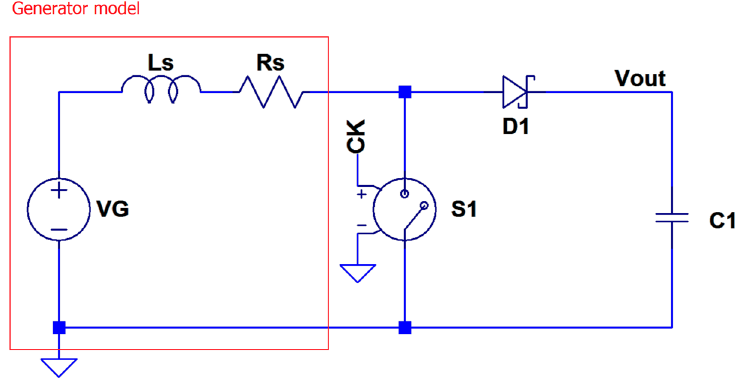
Figure 7. Simplifed boost converter circuit. J. Sens. Actuator Netw. 2016 , 5 , 15